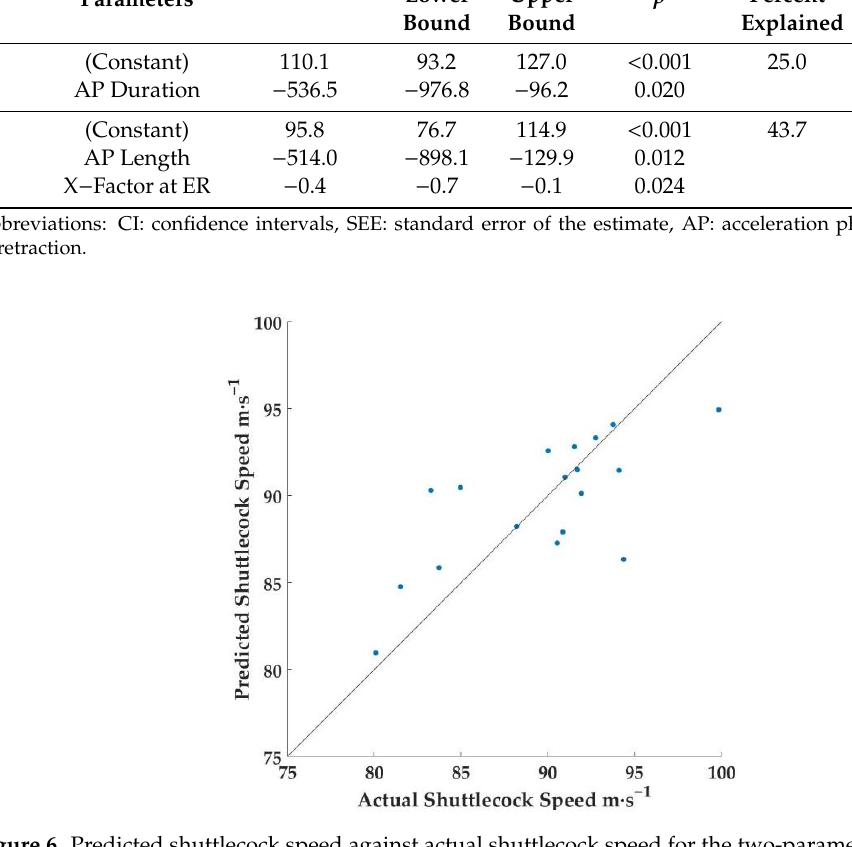
Figure 6. Predicted shuttlecock speed against actual shuttlecock speed for the two-parameter stepwise regression equation (Table 5; Model b). With a higher percentage of the variation in shuttlecock speed explained the closer the data points lie to the line y = x (predicted shuttlecock speed = actual shuttlecock speed).